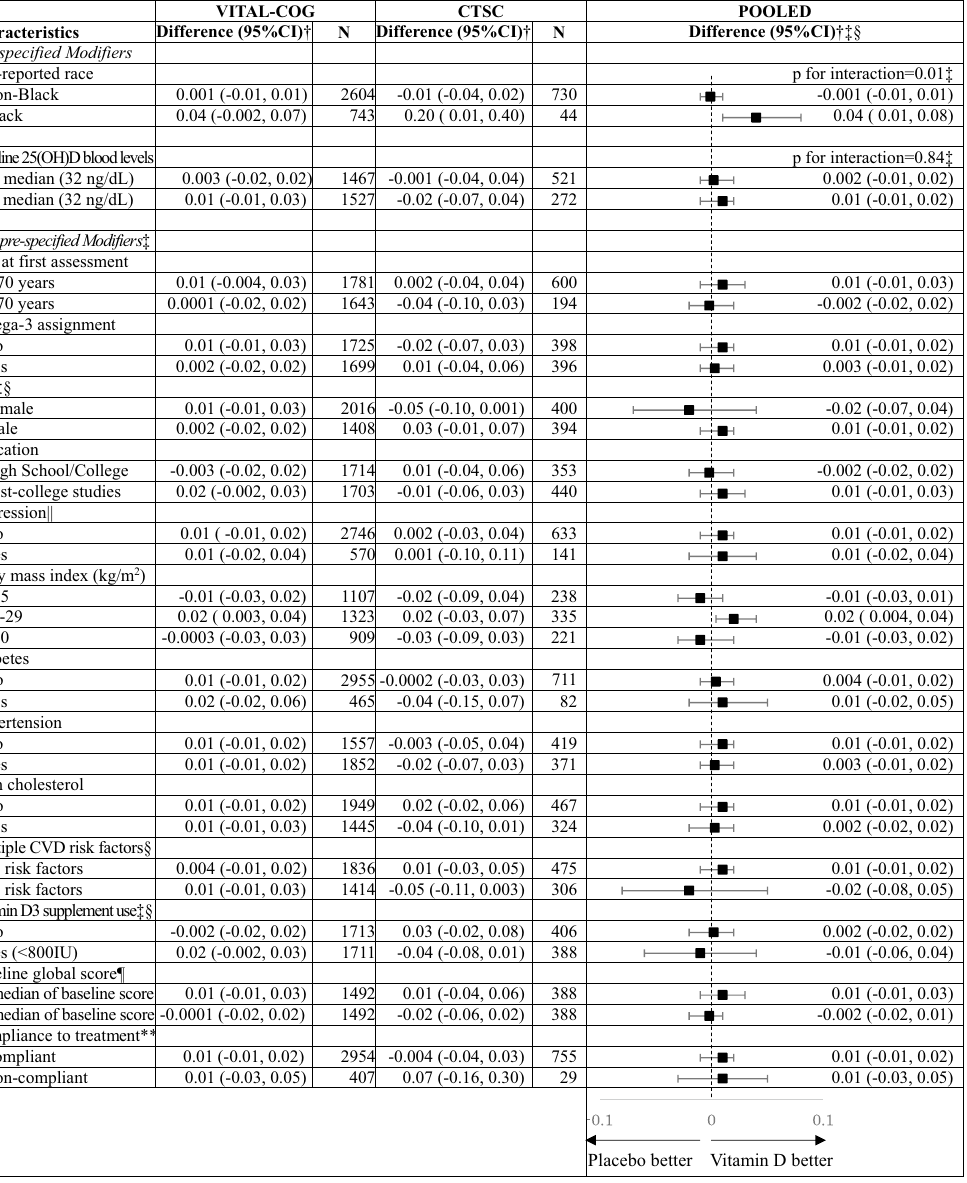
Table 4. Mean difference (95% CI) in rate of change in global score between vitamin D and placebo group: effect modification by risk factors for cognitive decline. CI confidence interval; CTSC-Cog , subset that received in-person interviews at the Harvard Clinical and Translational Science Collaborative center for VITAL in Boston, MA; CVD cardiovascular disease; VITAL-Cog subset that received telephone cognitive interviews in VITAL. For definitions of the global scores for the two populations, see footnote for Table 2. a Mean difference in annual rate of decline of vitamin D—placebo groups from multivariable-adjusted linear mixed models: see footnotes for Table 3. The stratified analyses were done among those with non-missing data on the effect modifier. b Interaction terms across the two substudies were pooled using Dersimonian and Laird fixed-effects method for meta-analysis. There was significant heterogeneity (p < 0.05) for two pooled p-interactions, and for these, random effects were incorporated into the meta-analysis; the pooled p-for interaction was 0.48 for sex and 0.66 for Vitamin D supplement use (< 800 IU) outside of the trial. None of the interaction terms for the non-pre-specified modifiers were significant at the Bonferroni-adjusted p-value of 0.0038 (= 0.05/13 subgroup analyses): pooled p for interaction ≥ 0.18. c Stratum-specific estimates were pooled using Dersimonian and Laird fixed-effects method for meta-analysis. There was significant heterogeneity (p-het < 0.05) for three strata, and for these, random effects were incorporated into the meta-analysis and presented in the Table. For reference, the fixed effects meta- analyzed pooled estimates were: 0.004 (95% CI − 0.01, 0.02) for females (p-het = 0.03), 0.003 (95% CI − 0.02, 0.02) for those with multiple CVD risk factors (p-het = 0.04) and 0.01 (95% CI − 0.01, 0.02) for those using Vitamin D supplements (< 800 IU) outside of the trial (p-het = 0.03). d See footnote in Table 1 for definition of depression. e Median for the global score was 0.05 in both the VITAL-Cog and the CTSC-Cog. f Compliance is defined as taking ≥ 2/3rd of pills on all of the follow-up questionnaires between the first and the second cognitive assessment and not initiating out-of-study fish oil